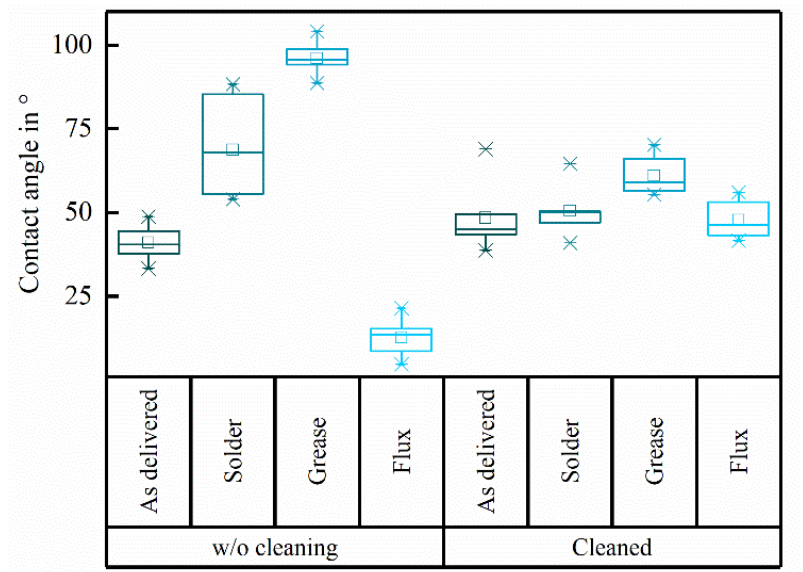
Figure 3. Contact angles of different contaminations before (n = 9) and after (n = 6) cleaning in “Leslie’s soup”, isopropanol and DI-water followed by an ultrasonic treatment. After performing the full cleaning procedure the contact angle of the initially “as clean as delivered”, solder and flux contaminated substrates was 48.4 ± 10.6 ◦ , 50.5 ± 7.8 ◦ and 47.8 ± 58 ◦ respectively. The contact angle of the initially grease contaminated substrate was higher (61.0 ± 5.9 ◦ ) after cleaning compared to the other groups. There were signifi- cant variations comparing the contact angles after cleaning of the different contaminated samples (F = 75.02, p < 0.001; ANOVAoneWay). Specifically, there were significant changes in the contaminations Solder, Grease and Flux (each p < 0.01; Fisher test), whereas clean- ing had no significant effect on the contact angles of the "as clean as delivered" sample (p w/o-w/cleaning, as delivered = 0.093; Fisher test). Despite the significant differences between the contaminations before cleaning (each p < 0.001; Fisher test), the multicomparison showed that there were no significant differences between the “as clean as delivered”, solder and flux left after treating the samples with the cleaning procedure. However, the contact angle of grease after cleaning was significantly higher compared to “as clean as delivered” ( p as delivered-grease = 0.011), solder ( p solder-grease = 0.031) and flux contaminations after cleaning ( p flux-grease = 0.007; Fisher test). The significance of an initial cleaning step with “Leslie’s soup” was demonstrated on substrates contaminated with grease and flux. For this purpose, the first step "swaying in “Leslie’s soup” for 5 minutes" was omitted when cleaning the substrates. Accordingly, after cleaning only with isopropanol and deionised water, the contact angles were 76.1 ± 9.1 ◦ (n = 9) for flux contaminants and 103.5 ± 6.4 ◦ (n = 9) for grease contaminants. The same contaminations were removed with “Leslie’s soup” only, neglecting the subsequent cleaning steps. Here, the contact angles were in both cases smaller than the detection limit of 10 ◦ (n = 9